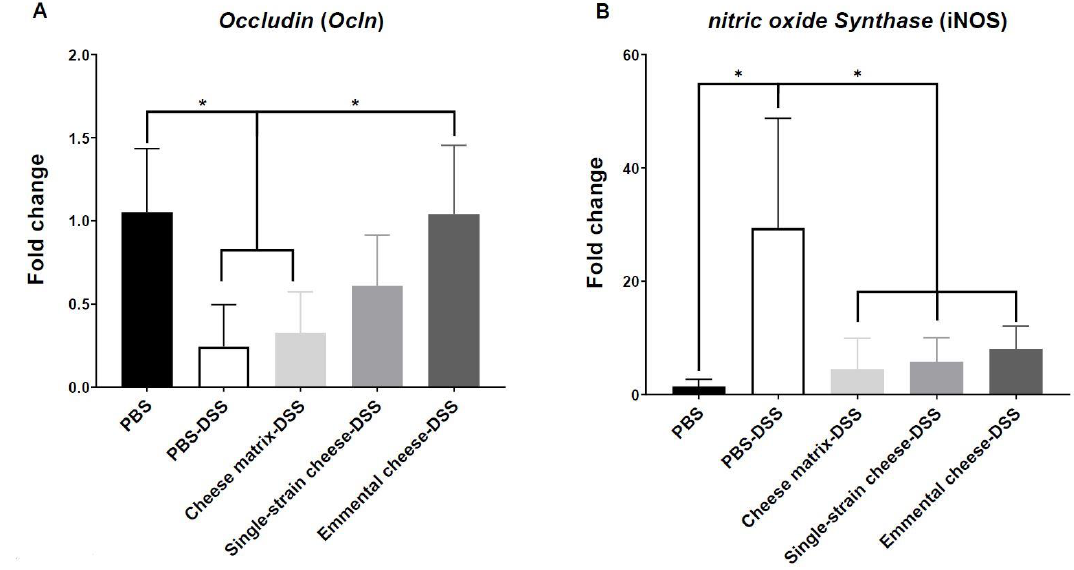
Figure 6. Impact of cheese matrix, single-strain cheese and Emmental cheese on colonic expression of markers of cell barrier and oxidative stress. Colonic mRNA expression levels of ( A ) Ocln and ( B ) iNOS genes were analysed. The data represent the mean ± SD of 6 mice per group. Groups were as follows. PBS: healthy group gavaged using PBS buffer as a sham. PBS-DSS: DSS-treated-colitis control group gavaged using PBS buffer as a sham. Cheese matrix-DSS: DSS-treated group gavaged using a germ-free dairy matrix. Single-strain cheese-DSS: DSS-treated group gavaged using an experimental single-strain cheese containing P. freudenreichii CIRM-BIA 129 as a sole bacterium. Emmental-DSS: DSS-treated group gavaged using an industrial Emmental cheese produced using P. freudenreichii CIRM-BIA 129 as a ripening starter. Multiple comparisons were performed, * p < 0.05, ** p < 0.01, *** p < 0.001 **** p < 0.0001.